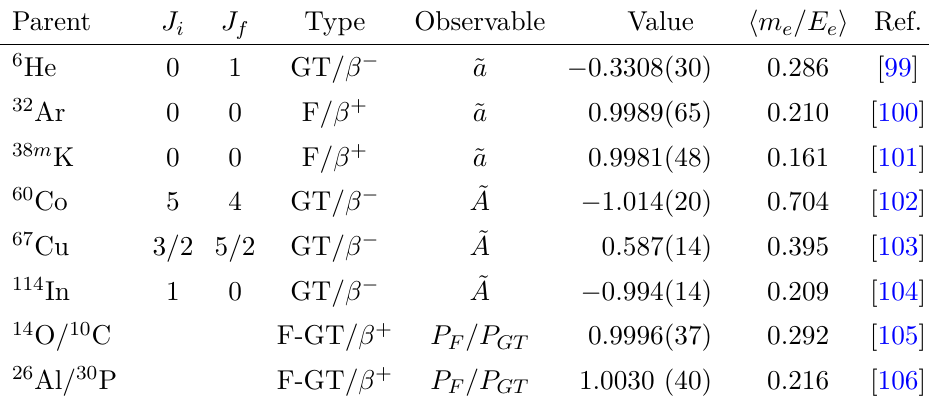
Table 10 . Data from correlation measurements in pure Fermi and pure Gamow-Teller decays used in the